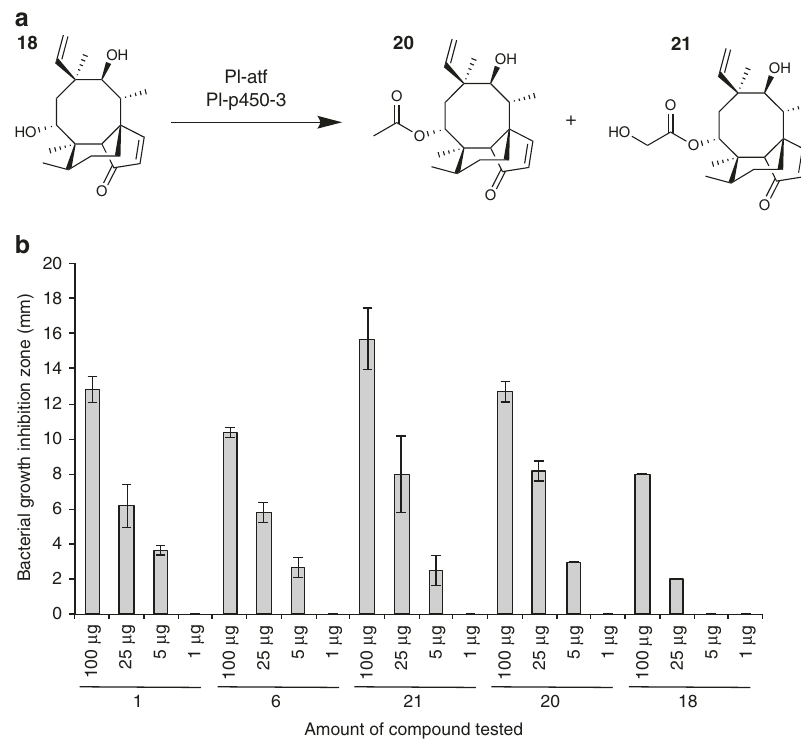
Fig. 5 Semi-synthetic bioactive pleuromutilin derivatives. a Bio-conversion of the enone 18 into its ester 20 and hydroxy ester 21 . b Antimicrobial activity of the semi-synthetic derivatives 20 and 21 against B. subtilis , compared to that of their precursor 18 , and the naturally occurring 1 and 6 . Error bars represent standard deviation of the bacterial growth inhibition zone calculated from three independent